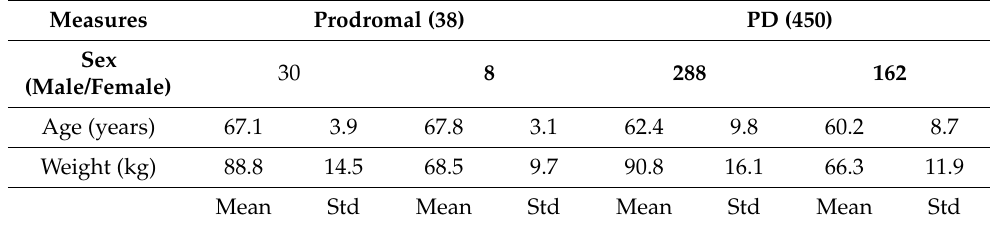
Table 2. Characteristics of the cohort of Prodromal and PD images used in this contribution. Measures